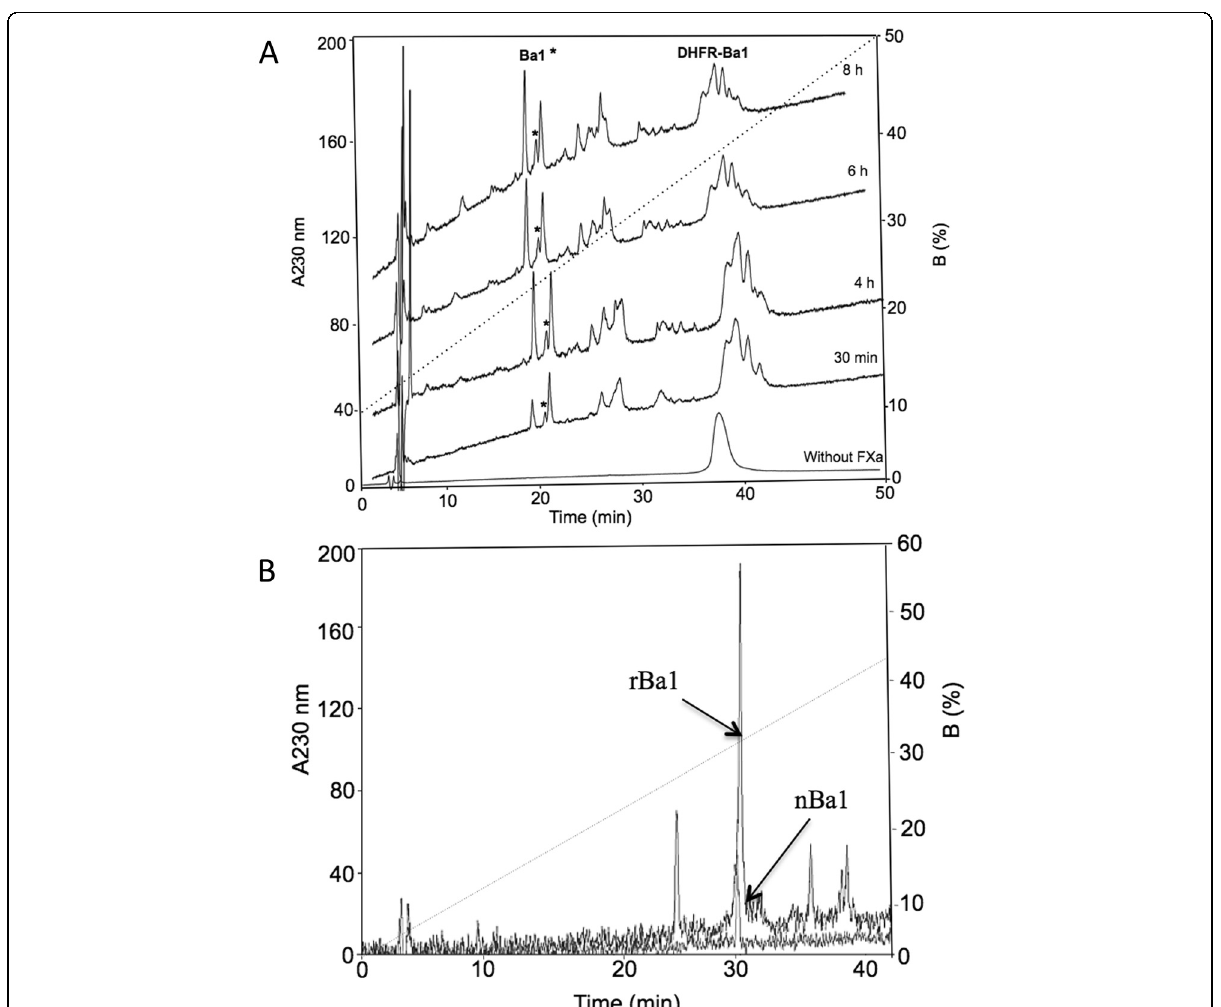
Fig. 5 rpHPLC separation of rBa1 from HisrDHFRBa1 and HisrBa1 using FXa. (a) Enzymatic hydrolysis of HisrDHFRBa1 using FXa where rBa1 (asterisk) was separated by rpHPLC (C 18 column) with a gradient from 10 to 60 % B in 50 min at 1 mL/min. (b) Enzymatic hydrolysis of HisrBa1 using FXa, rBa1 was separated by rpHPLC (C 18 column) with a gradient from 0 to 60 % B in 60 min at 1 mL/min. A superimposed chromatographic rpHPLC profile under the same elution conditions shows the retention time of the nBa1. The fact that rBa1 and nBa1 eluted at the same retention time suggests similar secondary and tertiary